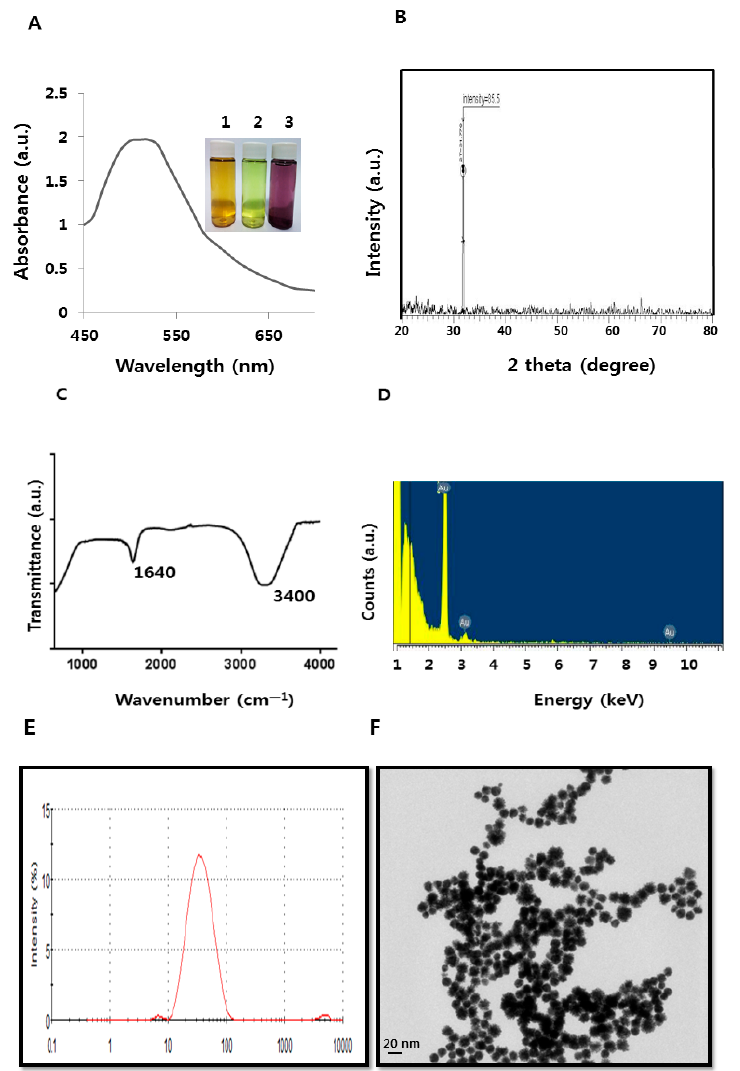
Figure 1. Synthesis and characterization of gold nanoparticles (AuNPs) using Bacillus clausii. ( A ) The absorption spectrum of AuNPs synthesized by B. clausii culture supernatant. The inset shows tubes containing samples of the B. clausii supernatant after exposure to 1 mM aqueous HAuCl 4 for 2 h (1), supernatant (2), HAuCl 4 (3) HAuCl 4 plus supernatant. The color of the solution turned from pale yellow to purple after 2 h of reaction time, indicating the formation of AuNPs; ( B ) X-ray diffraction spectrum of AuNPs; ( C ) FTIR spectra of AuNPs; ( D ) EDX spectra of AuNPs; ( E ) Size distribution analysis of AuNPs by DLS; ( F ) Size and surface morphology analysis of AuNPs by TEM.